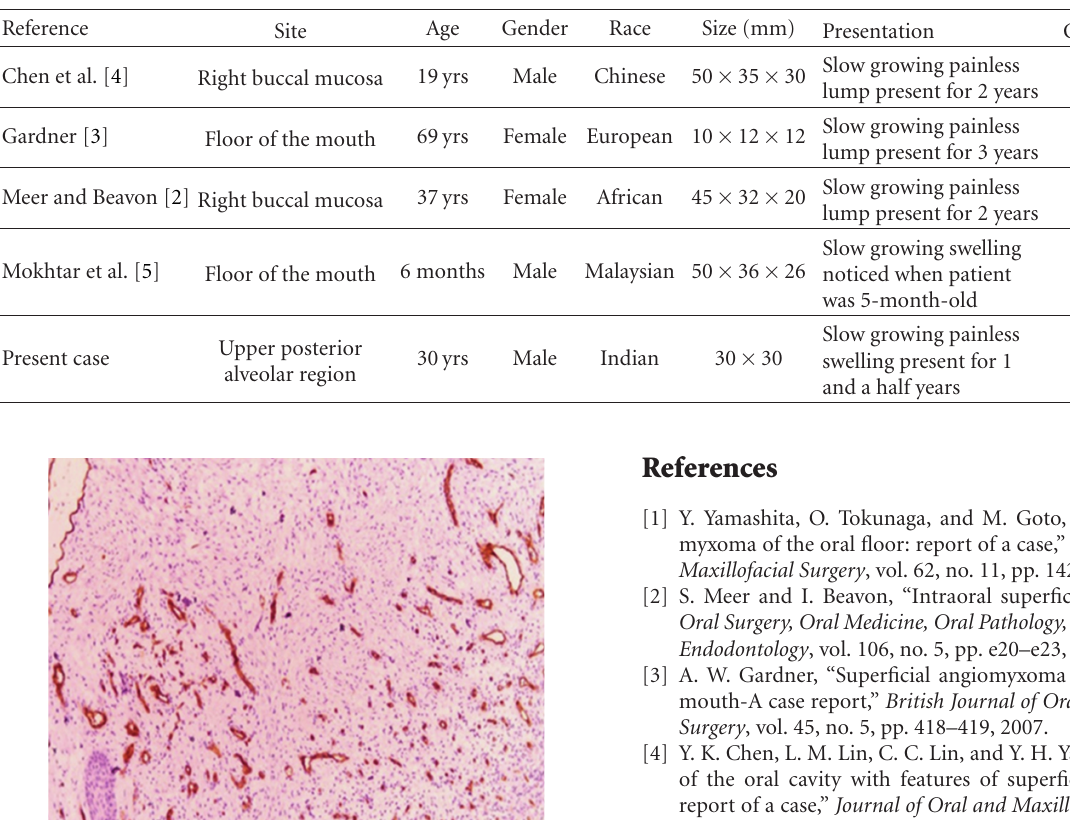
Table 1: Reported cases of intraoral superficial angiomyxoma.